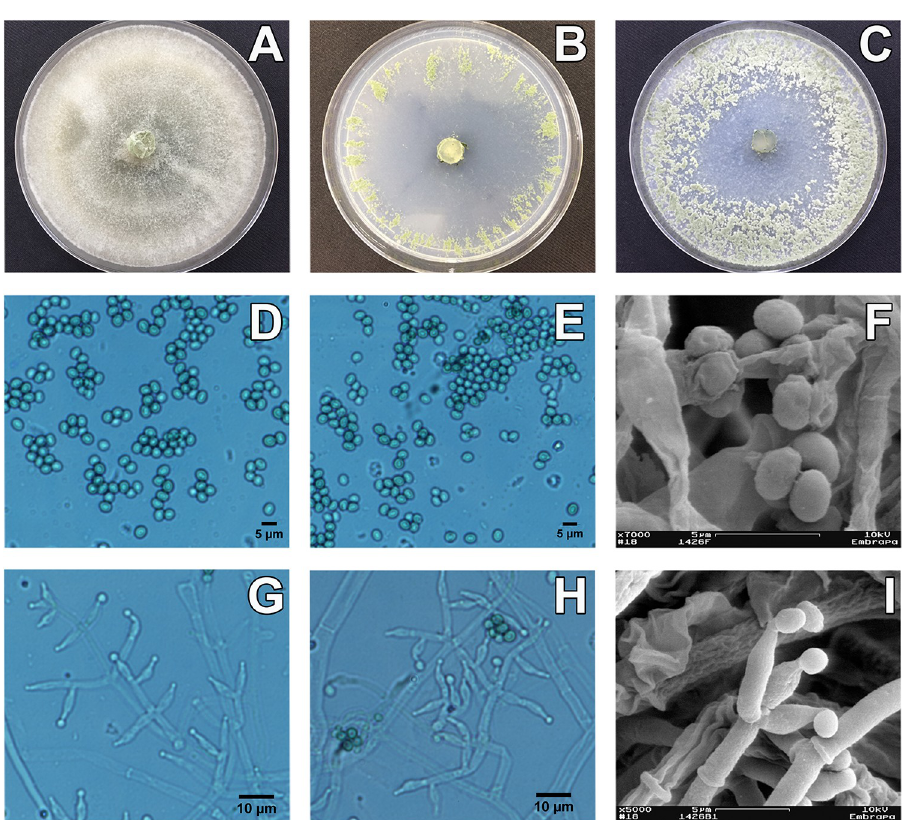
Fig 4. Culture characteristics and morphology of T . peberdyi sp. nov. strain CEN1426 (holotype). Panels A-I: Growth on three different media, PDA (A); SNA (B); CMD (C); and morphology of the conidia (D, E) and phialides using optical microscopy (G, H) and conidia using electron microscopy (F,